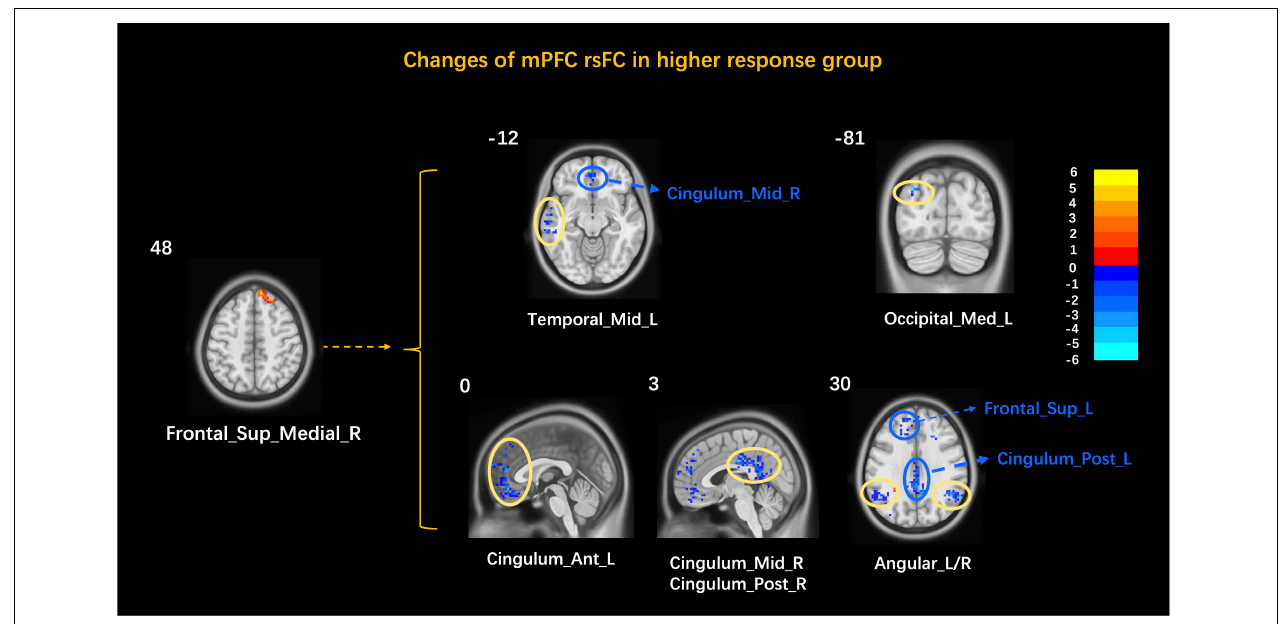
FIGURE 3 | Changes of the mPFC rsFC in the higher response group. Frontal_Sup_Medial, medial prefrontal cortex; Temporal_Mid, middle temporal gyrus; Cerebelum_Crus1, cerebellum superior; Cingulum_Ant, anterior cingulate cortex; Cingulum_Mid, middle cingulate cortex; Cingulum_Post, posterior cingulate cortex; L, left; R, right. Yellow circles mark peak points and blue marks non-peak areas.